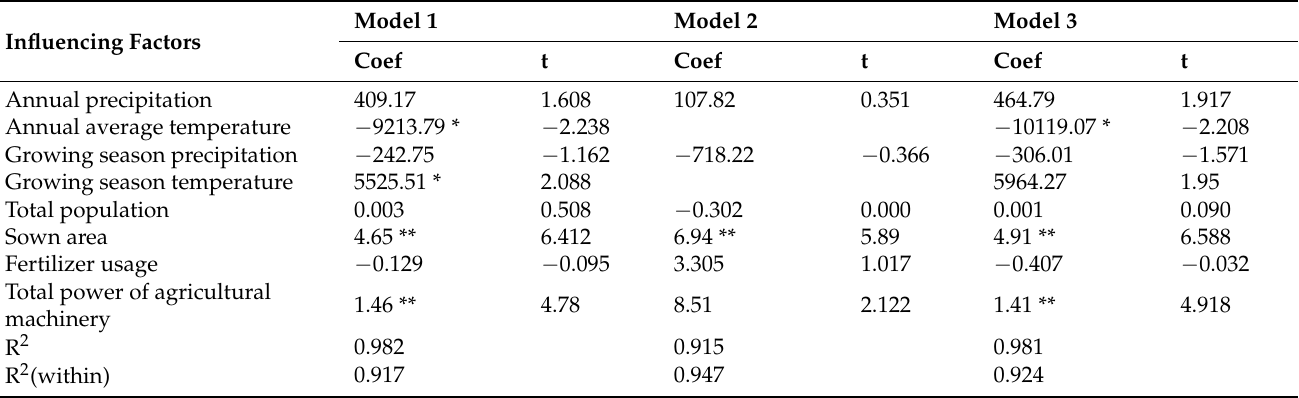
Table 4. Panel model